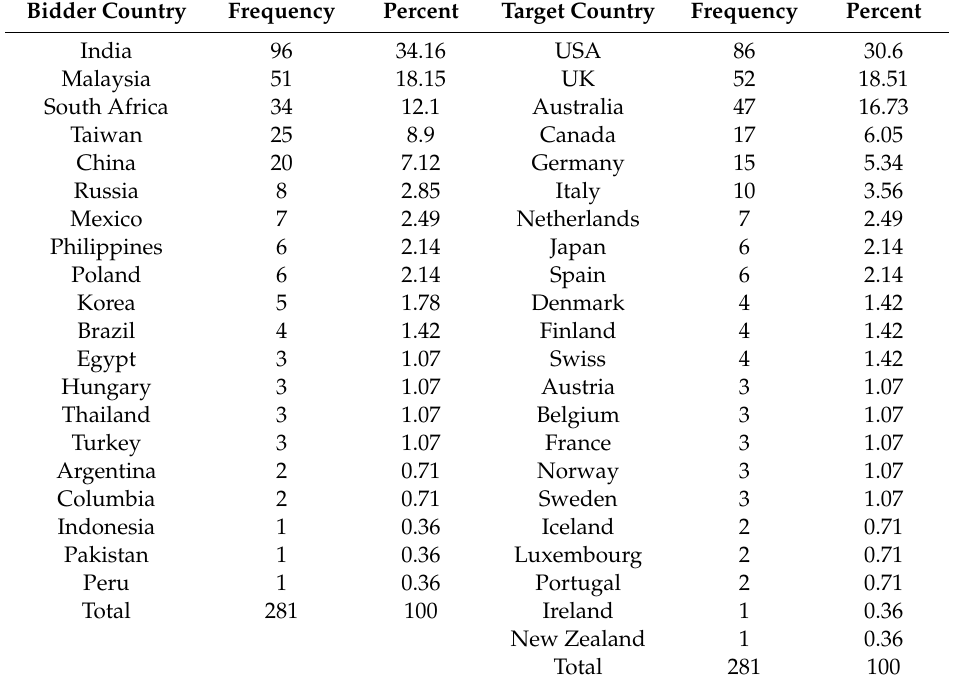
Table 2. Distribution of merger and acquisition (M&A) events by country (Source: authors’ calculations). Bidder Country